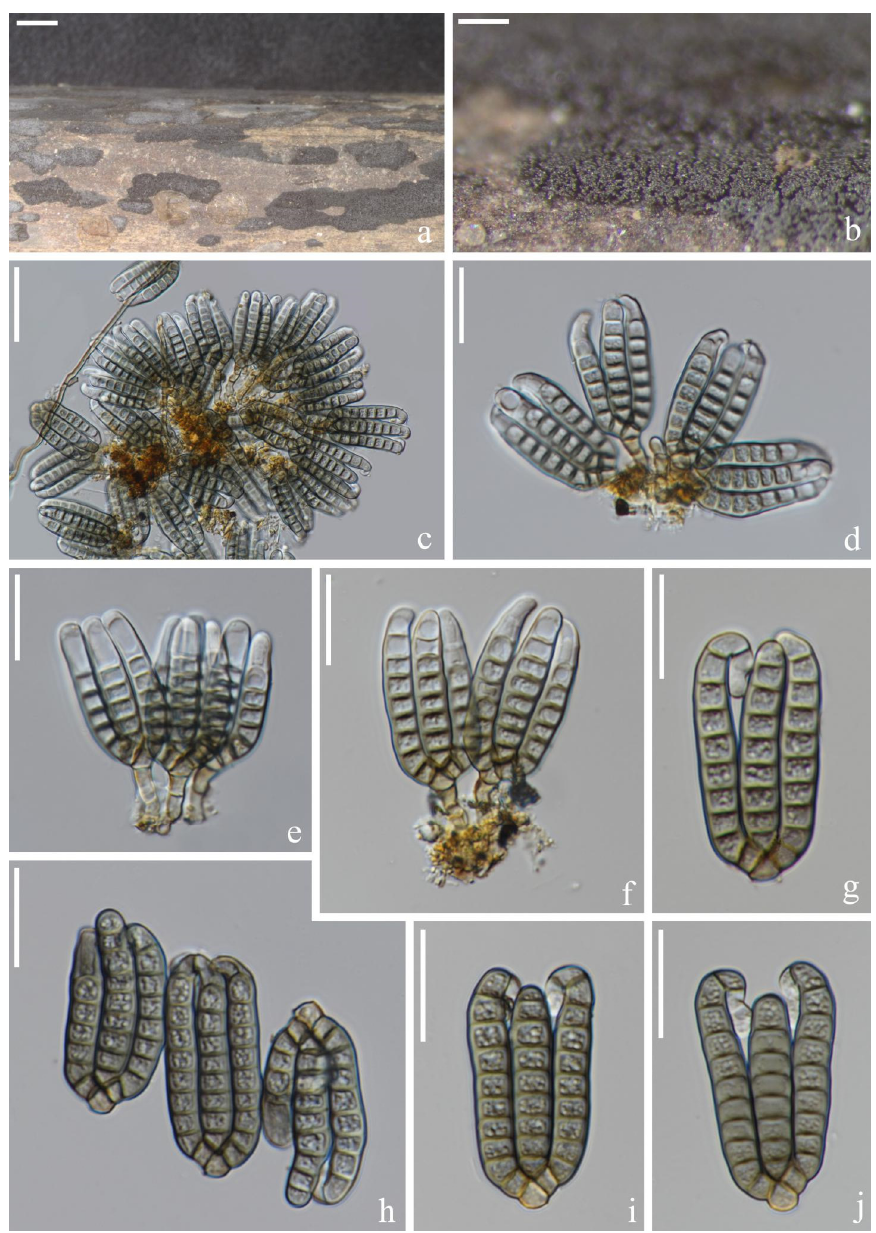
Figure 9. Digitodesmium aquaticum (MFLU 22-0203, holotype). ( a , b ) Colonies on the substratum. ( c –